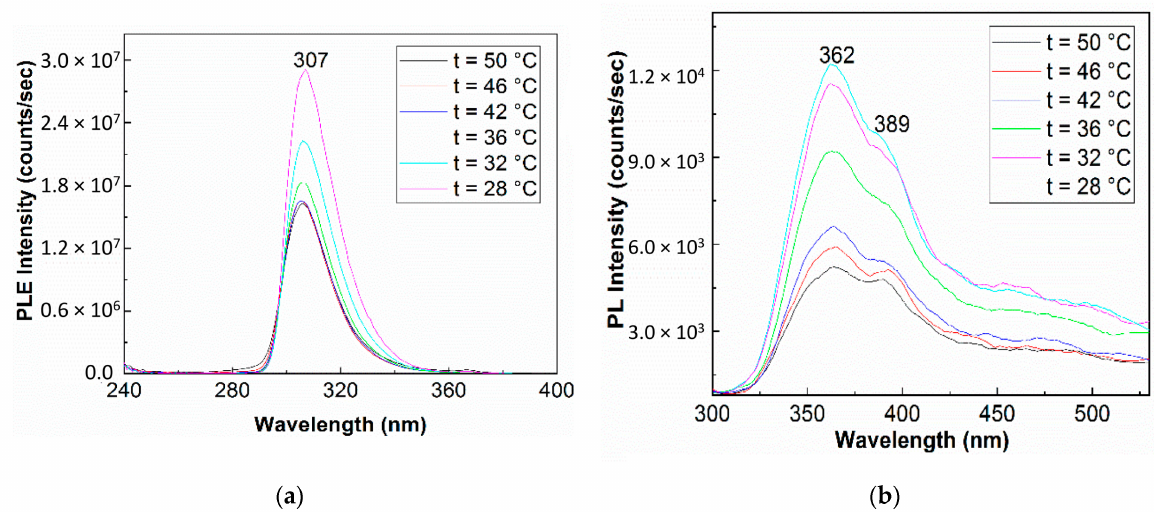
Figure 8. The dependence of the PLE ( a ) and PL ( b ) spectra of the aqueous solution of ASA 0.3 M with the temperature. All PLE spectra were recorded at the emission wavelength of 420 nm, while the PL spectra were recorded at the excitation wavelength of 275 nm.